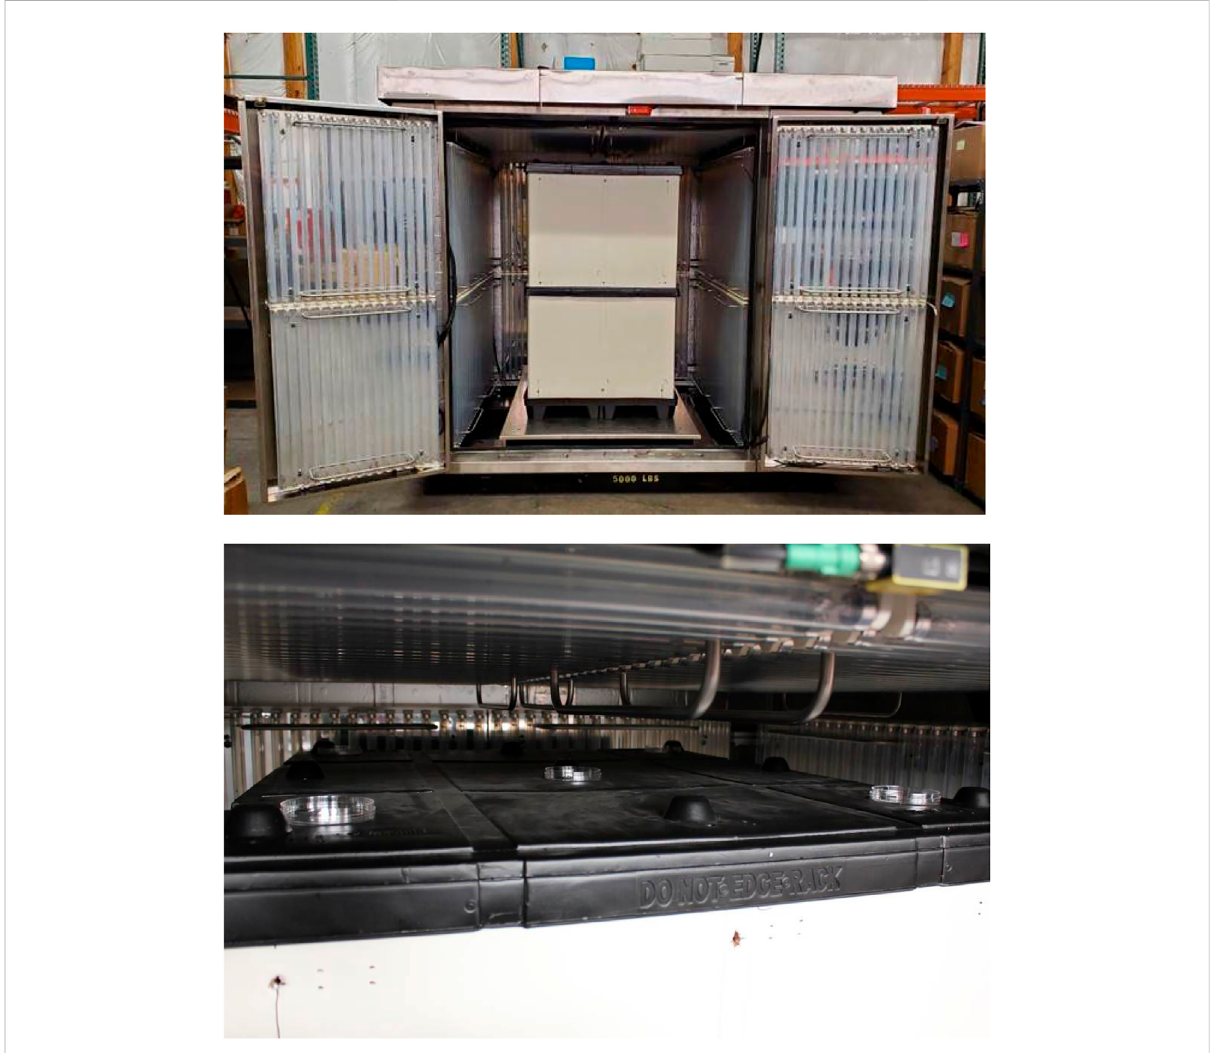
FIGURE 9 Prototype Big Box UV-C Chamber with a double-stacked pallet (top). Coupon placement was inside Petri plates on top of the pallet for testing